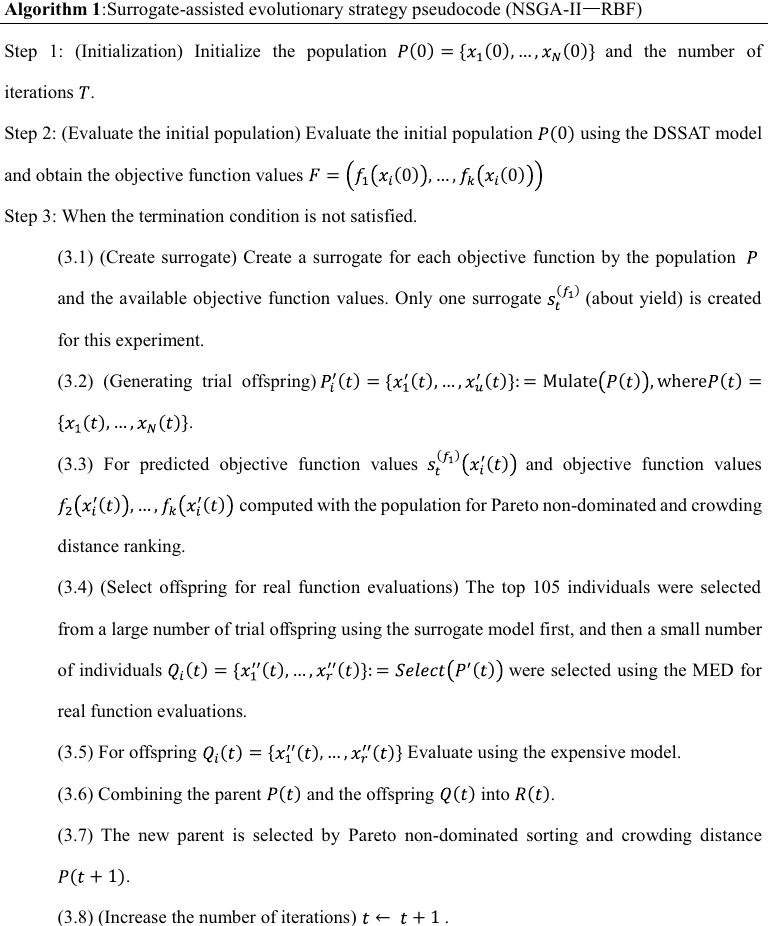
Algorithm 1 :Surrogate-assisted evolutionary strategy pseudocode (NSGA-II